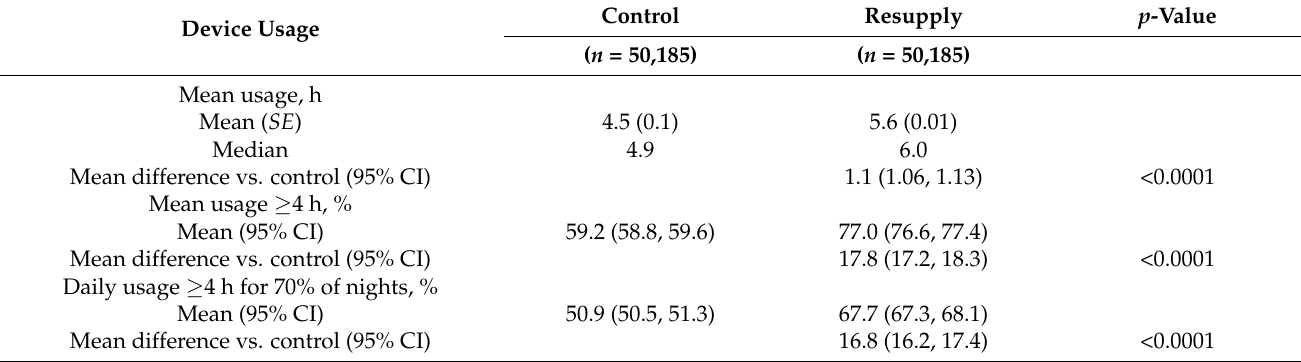
Table 2. Device usage and respiratory parameters from days 91 to 360 (primary analysis